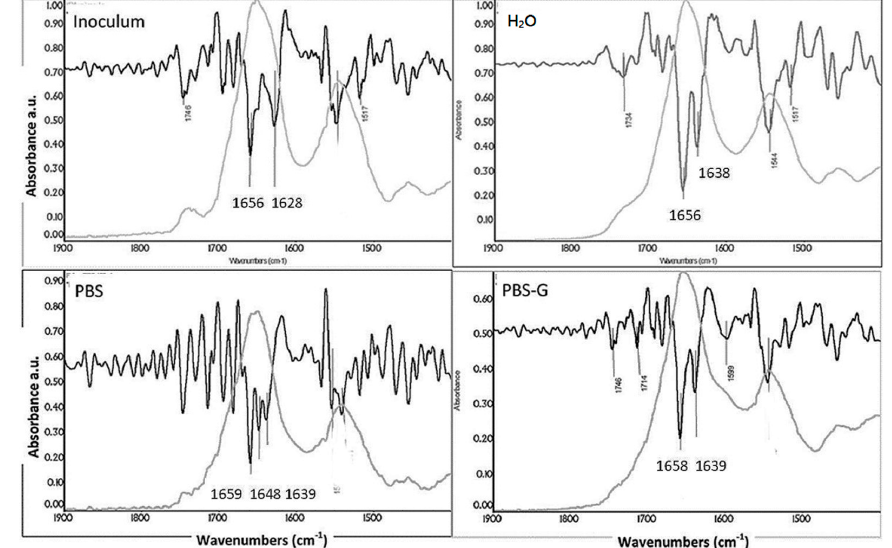
Figure 8. Second derivatives of the FTIR spectra of PF biofilms at Inoculum (upper left), in H 2 O (upper right), in PBS (lower left) and PBS-G (lower right) (for related spectra see Figure 6).